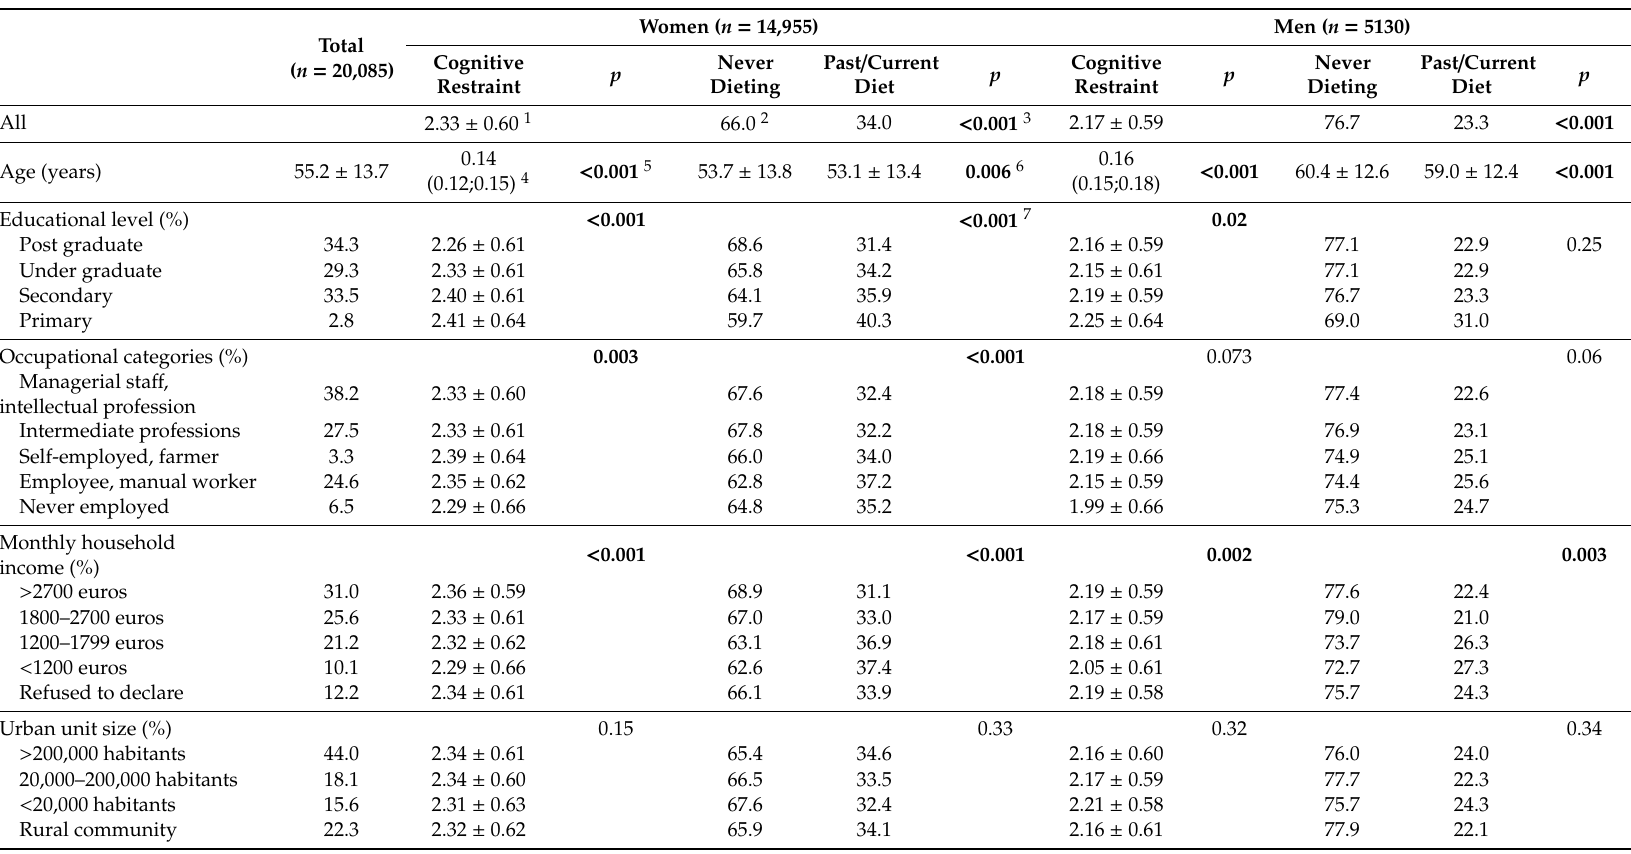
Table 1. Cognitive restraint level and history of dieting according to sociodemographic and lifestyle characteristics in 20,085 organic food consumers (NutriNet-Sant é study